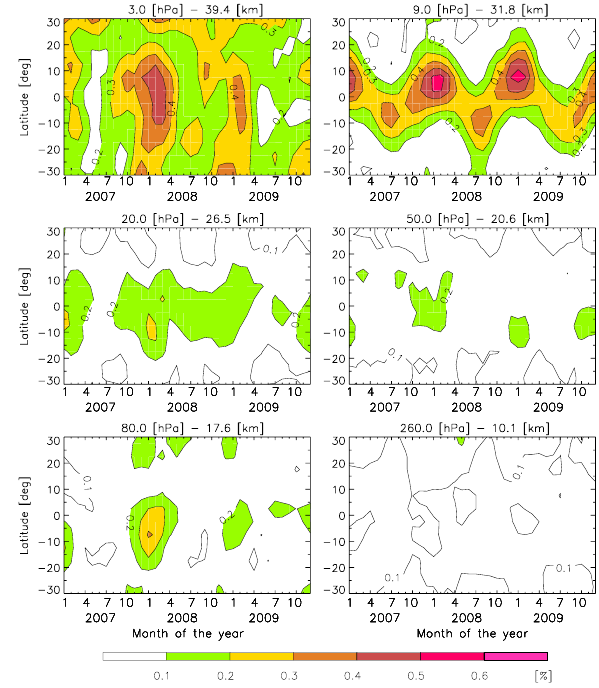
Fig. 3. Three-year time series of diurnal amplitude of refractivity (in percentage) at six pressure levels from 260hPa to